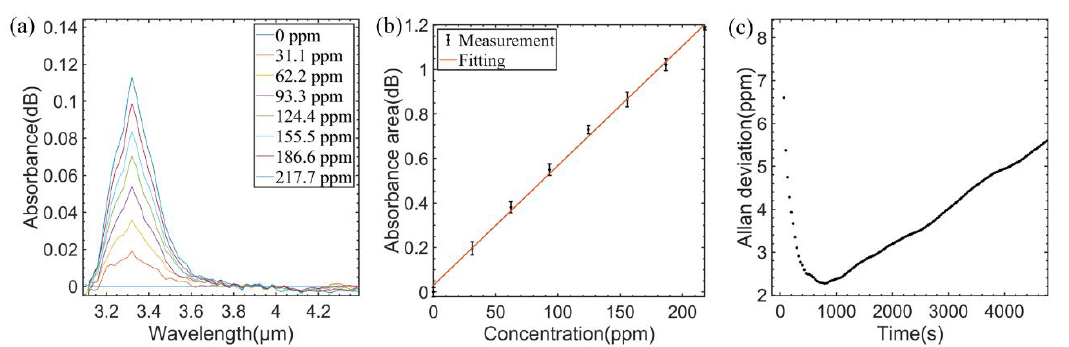
Figure 6. ( a ) Measured absorption spectra of different CH 4 concentrations. ( b ) Experimental data and fitting curve of CH 4 concentration versus absorbance area. ( c ) Allan variance analysis of the sensor for CH 4 . sensor for CH 4